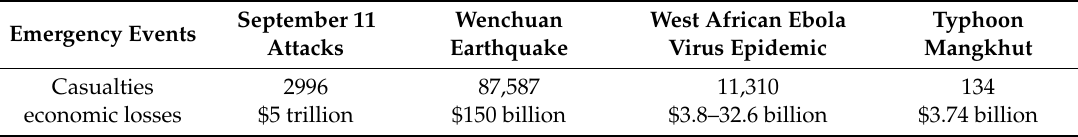
Table 1. The situation of casualties and enormous economic